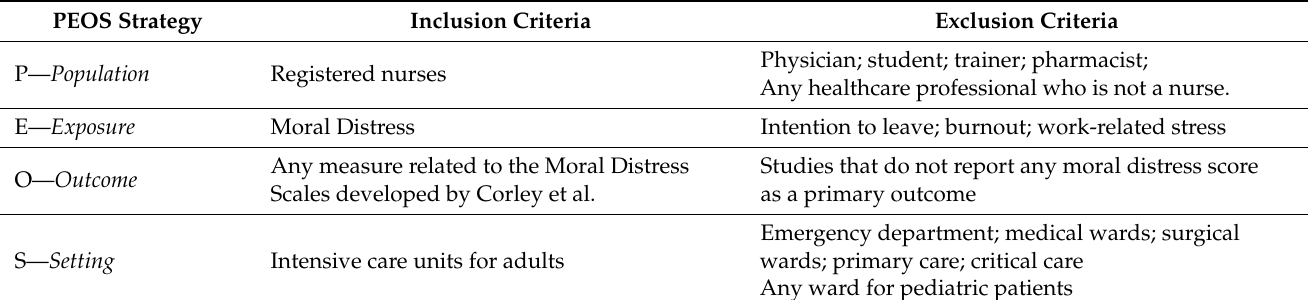
Table 1. Inclusion and exclusion